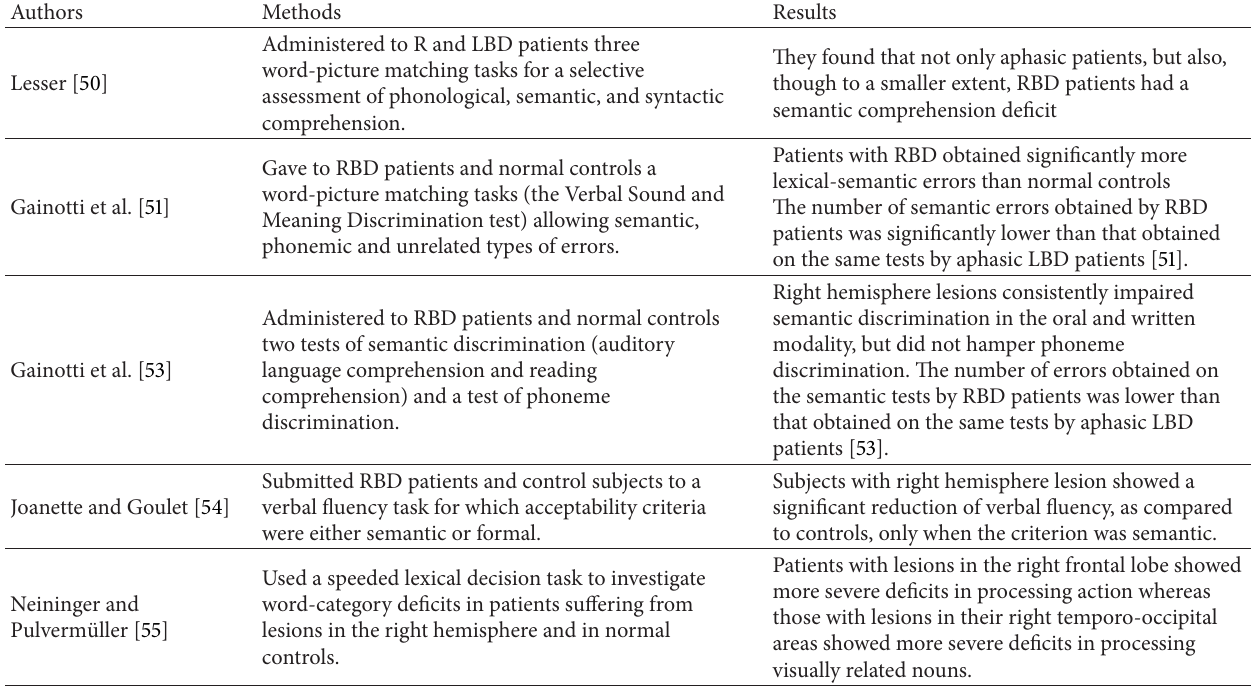
Table 3: Results of studies conducted on patients with unilateral brain-damage with tasks devised to test semantic-lexical disorders of right brain-damaged